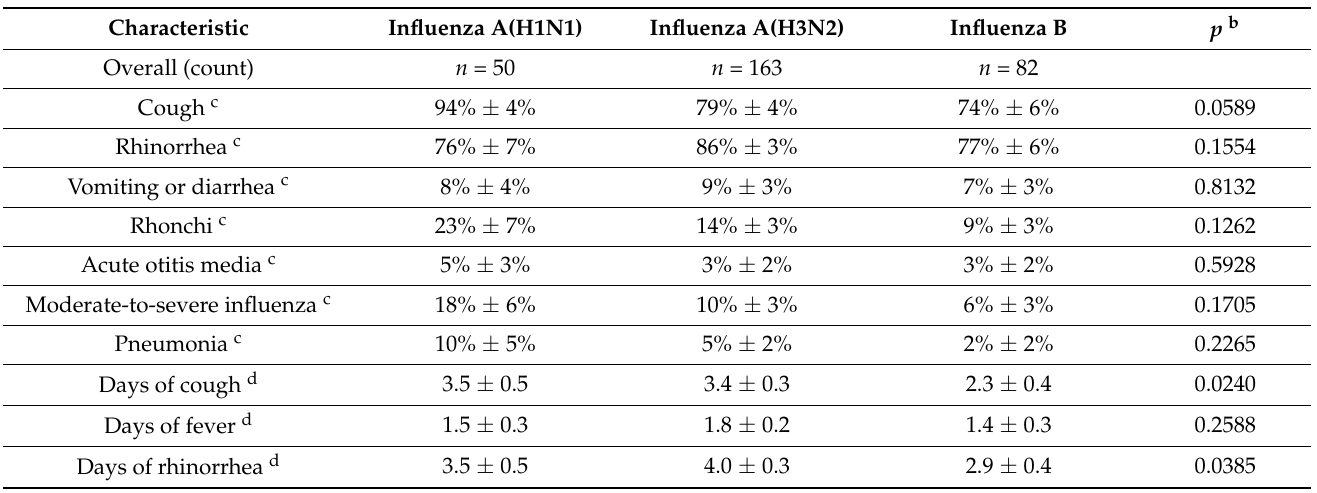
Table 4. Clinical and parent-reported outcomes (mean ± standard error) by influenza type for 295 a influenza episodes in a cohort of children <2 years in Managua,